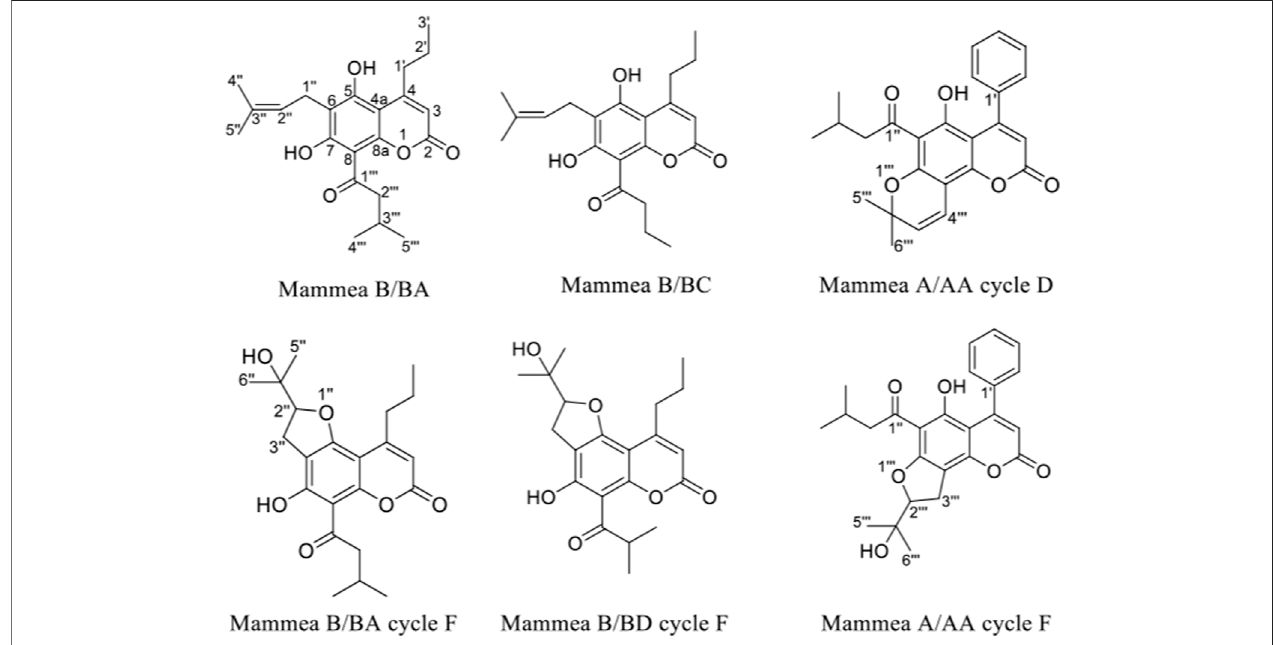
FIGURE 2 | Structures of coumarins isolated from the extract of the seeds of M. americana